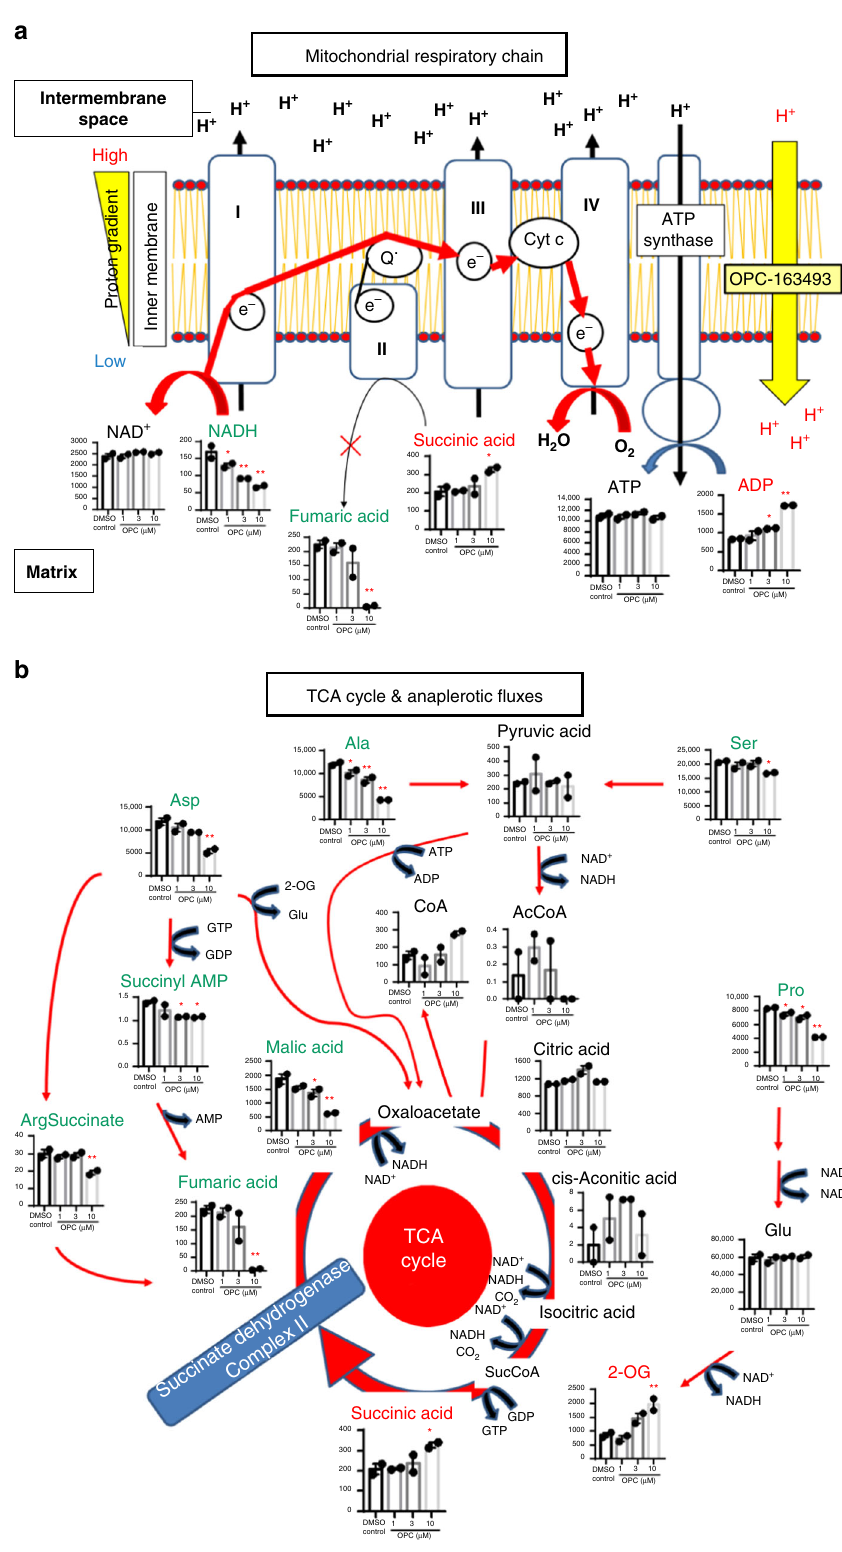
Fig. 5 Metabolomic analysis of in vitro effects of OPC-163493 in HepG2 cells. Data represent mean ± SE ( n = 2, ∗ P < 0.05, ∗∗ P < 0.01, OPC vs. DMSO control using a two-tailed Williams ’ test). a Effects on MRC. b Effects on the TCA cycle and anaplerotic fl uxes. AcCoA acetyl CoA, ArgSuccinate argininosuccinic acid, Succinyl AMP adenylosuccinic